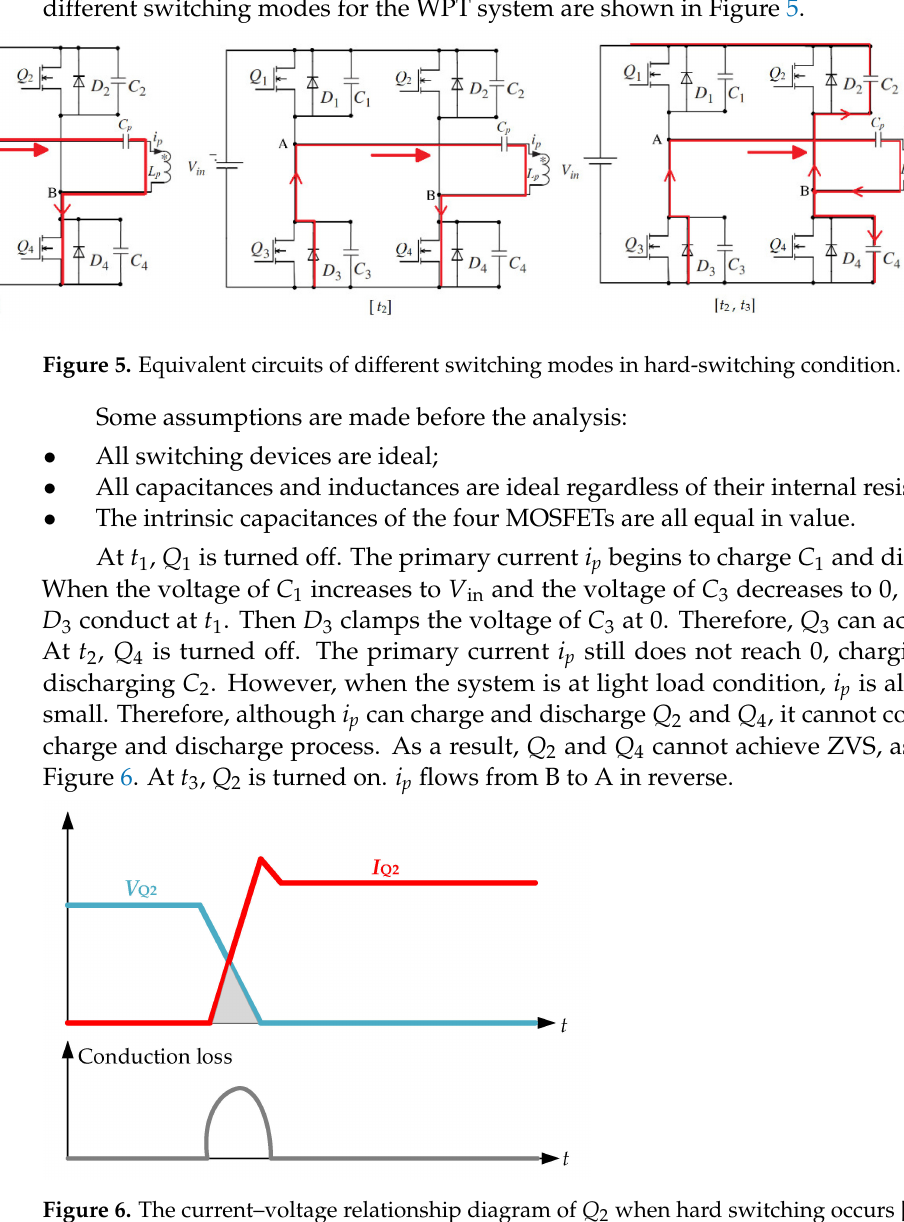
Figure 6. The current–voltage relationship diagram of Q 2 when hard switching occurs